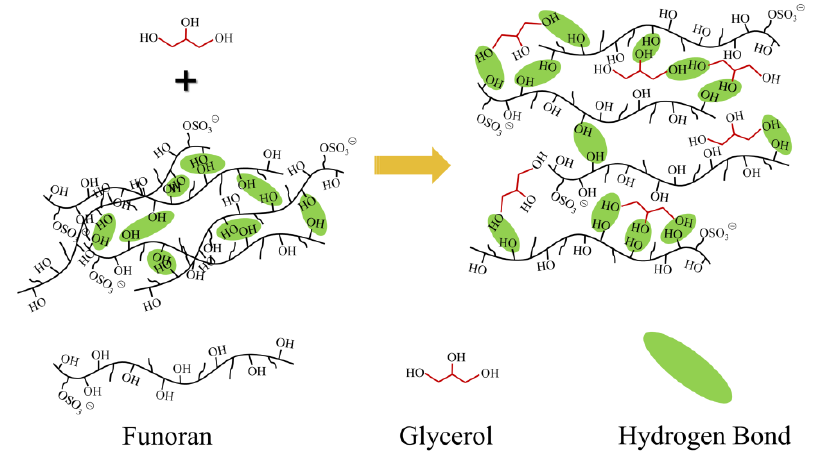
Figure 5. Film-forming mechanism diagram of the funoran films.